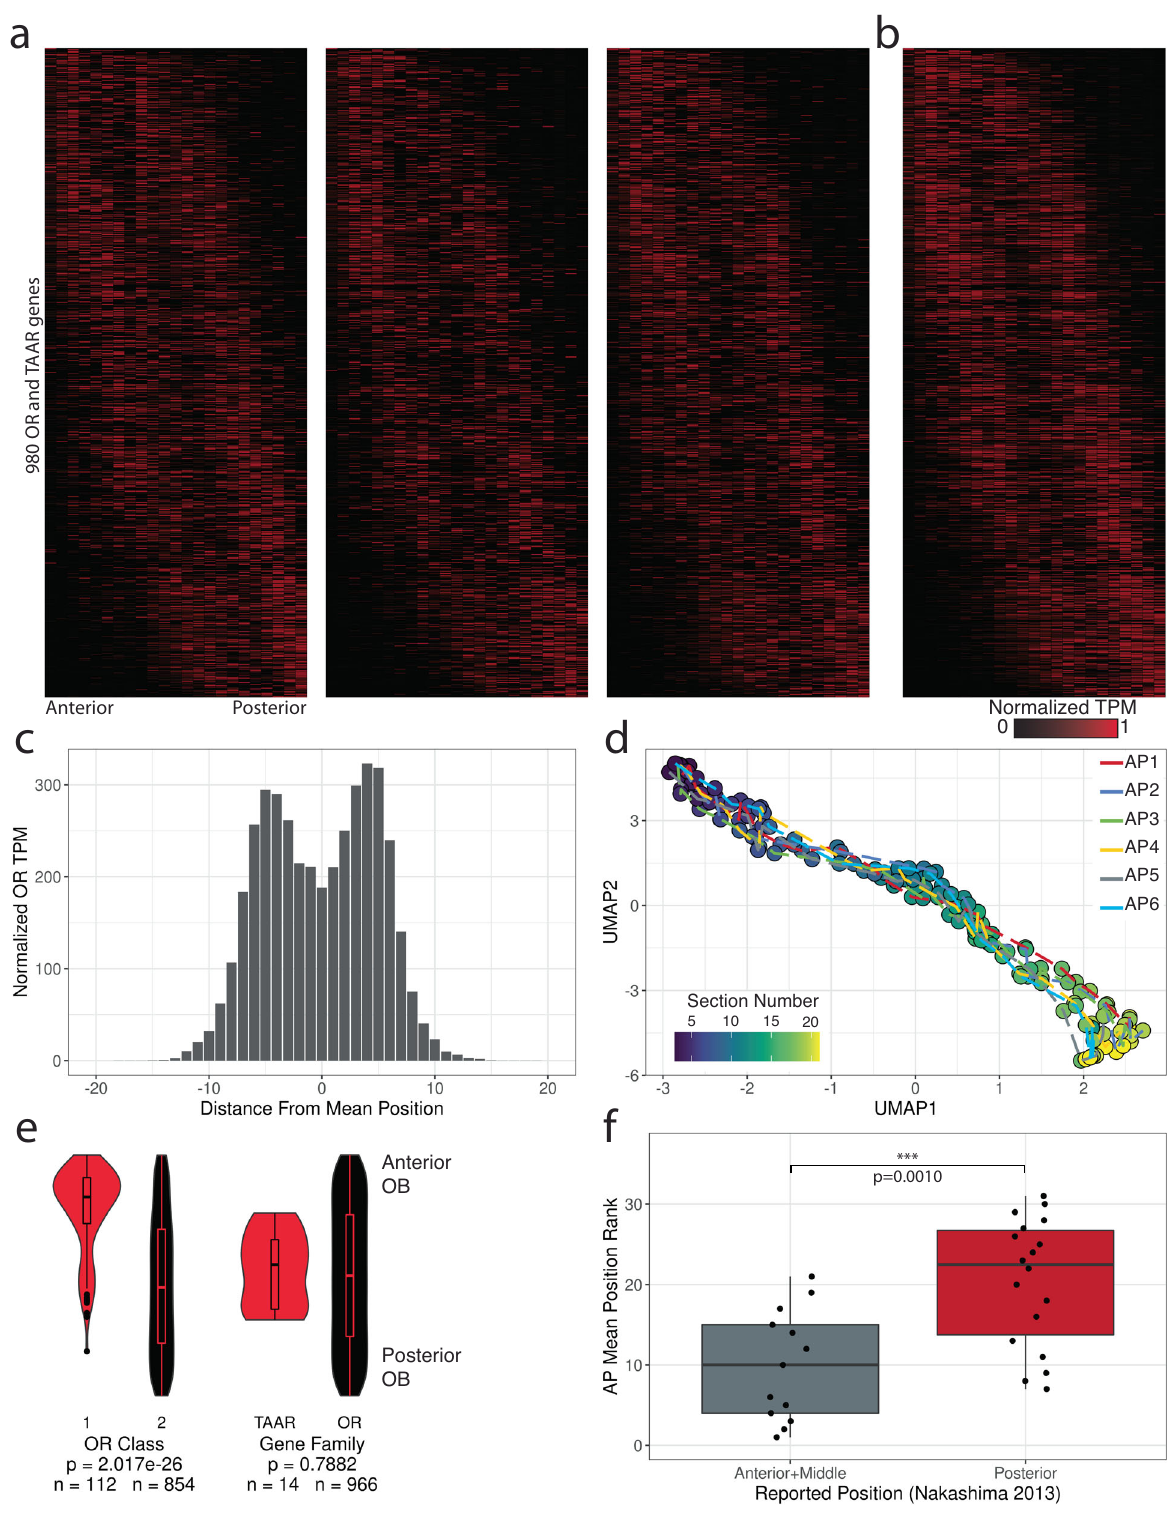
Fig. 3 | Glomerular OR gene expression is bimodally distributed along the anteroposterior axis. a Heatmaps for 980 OR and TAAR genes across 23 AP sections sorted by mean position of expression from three replicate mice. Source data provided as a Source Data fi le. b Merged representation from A. Ordering of genes is consistent across all heatmaps. c Distribution of normal- ized TPM (maximum observed value=1, minimum observed value = 0) for all 980 OR and TAAR genes from position of mean expression. d UMAP projection